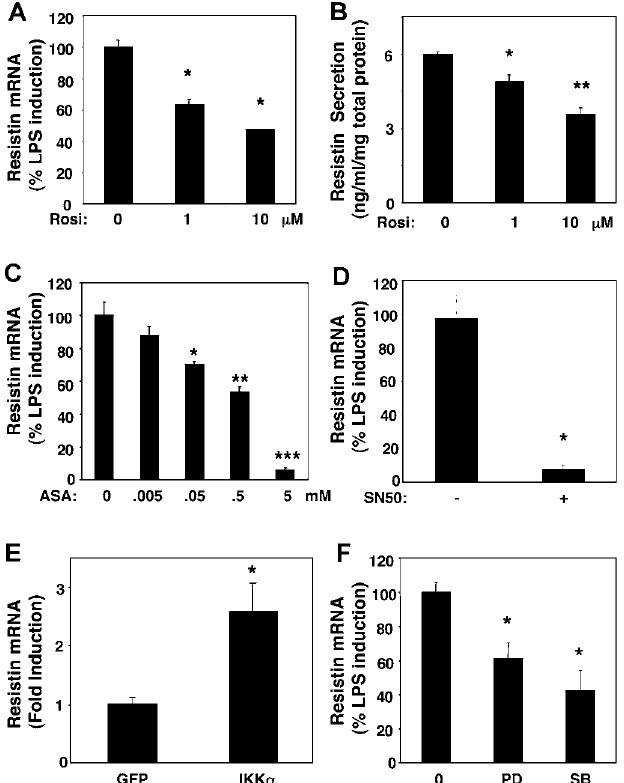
Figure 4. Inhibition of Resistin Induction by Anti-Inflammatory Insulin Sensitizers (A) Down-regulation of resistin mRNA by rosiglitazone. ANOVA F statistic for the effect Rosiglitazone on resistin expression was 62.52 ( p , 0.001). p value for post hoc t-tests, is depicted in the Figure. * p , 0.005 versus control for post hoc t -tests. (B) Down-regulation of resistin protein secretion by human macro- phages treated with rosiglitazone. The ANOVA F statistic for the effect of rosiglitazone on resistin protein secretion was 29.44 ( p , 0.001). p - Valuesforposthoc t -testsversuscontrol:*, p , 0.05;**, p , 0.001.Cells were pre-treated with rosiglitazone for 24 h and with LPS (1 l g/ml) and rosiglitazone for an additional 24 h. Results of representative experi- ments with triplicate samples are expressed as mean ( 6 SEM). Similar results were obtained in three independent experiments. (C) Down-regulation of resistin gene expression by aspirin. The ANOVA F statistic for the effect of aspirin on resistin expression was 61.33 ( p , 0.001). p -Values for post hoc t -tests versus no aspirin: *, p , 0.01; **, p , 0.001; ***, p , 0.0001. Cells were pre-treated with aspirin for 2 h and with LPS (1 l g/ml) and aspirin for an additional 24 h. Results of representative experiments with triplicate samples are expressed as mean ( 6 SEM). Similar results were obtained in two independent experiments. (D) Down-regulation of resistin gene expression by NF- j B inhibitor SN50. *, p , 0.001 versus control peptide by t -test. Cells were pre- treated with SN50 or control peptide at 100 ug/ml for 2 h, and with LPS (1 l g/ml) and SN50 or control peptide for an additional 24 h. Results are the expressed as the mean ( 6 SEM) of two independent experiments performed in triplicate. (E) Induction of resistin by activation of NF- j B. *, p , 0.05 versus control virus by t -test. Cells were infected with adenovirus expressing activated IKK or control virus for 24 h. Results of representative experiments with triplicate samples are expressed as mean ( 6